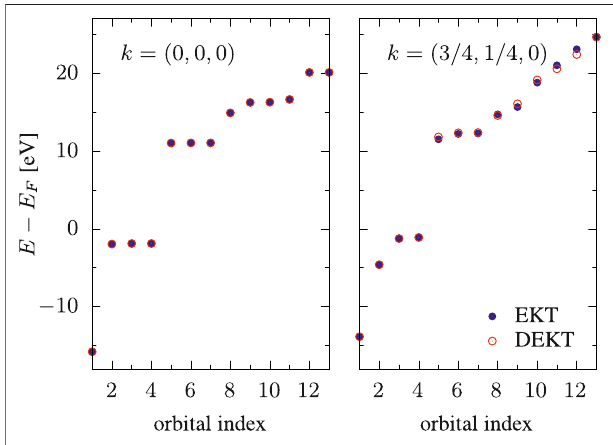
FIGURE 3 | Removal/addition energies of bulk Si: EKT ( fi lled circles) vs DEKT (empty circles) for two k -points, k (cid:2) (0, 0, 0) and k (cid:2) (3/4, 1/4, 0).